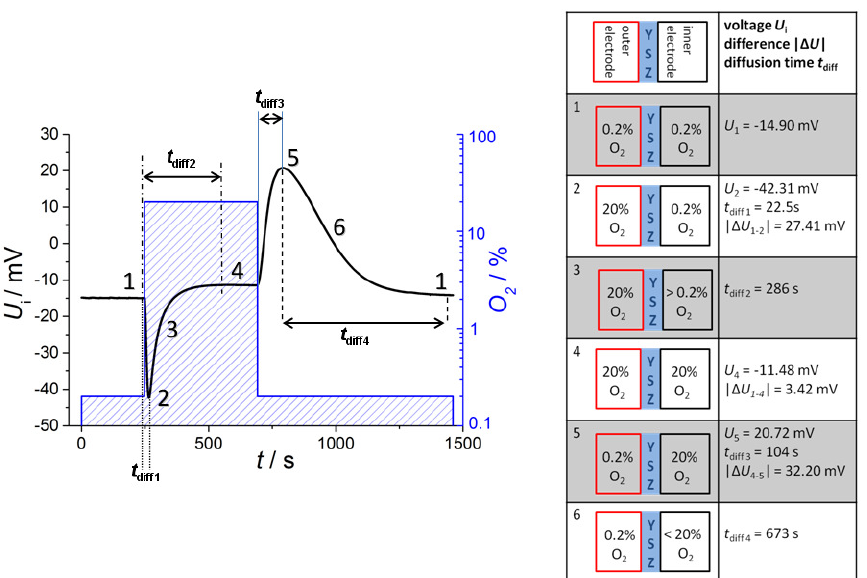
Figure 4. ( a ) Recorded voltage U concentration at the outer electrodes during phase 1 to phase 6, and corresponding voltages U , voltage differences | ∆ U i